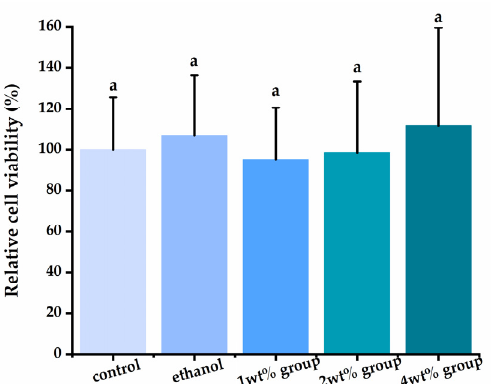
Figure 6. Evaluation of human dental pulp cells’ (HDPs’) viability exposed to different quercetin- containing mediums. Groups with the same letters are not statistically different ( p >